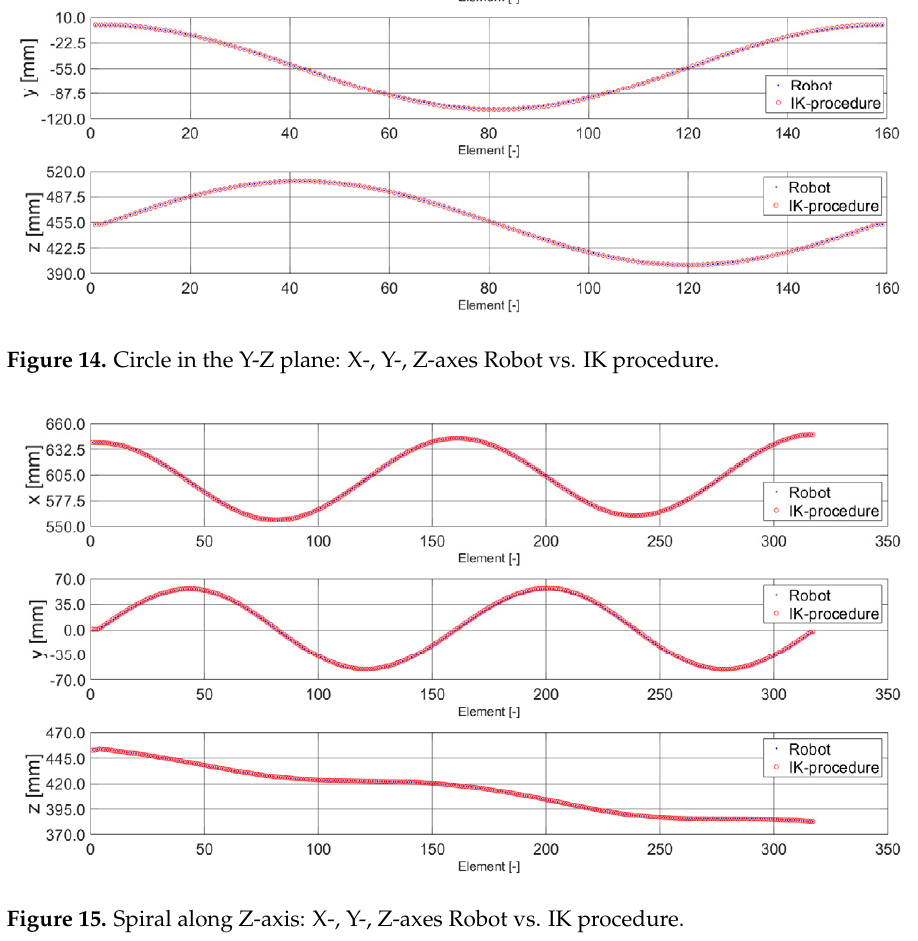
Figure 17. S-shape in the X-Y plane: X-, Y-, Z-axes Robot vs. IK procedure.